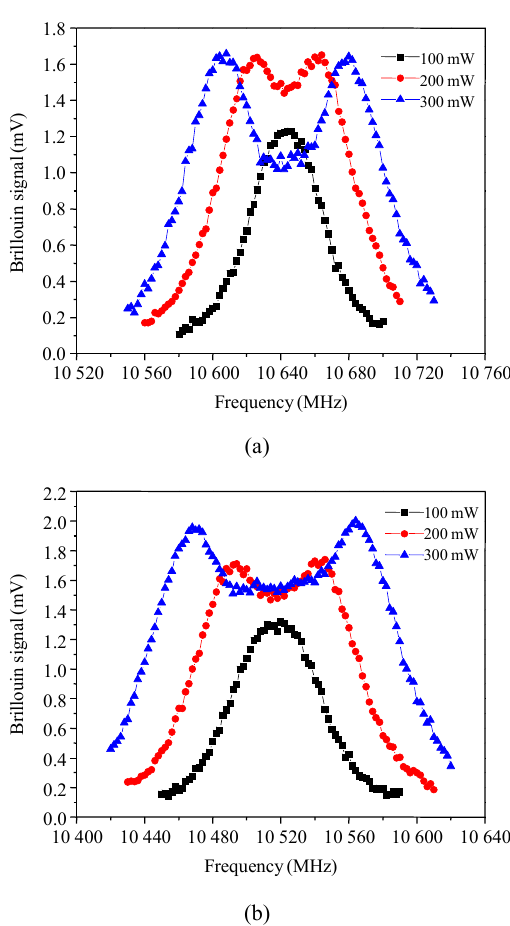
Fig. 6 Measured BGSs at the end of the 25-km fibers with a 50-ns Gaussian pump pulse at different powers for (a) LEAF fiber (anomalous dispersion) and (b) MetroCor fiber (normal dispersion)